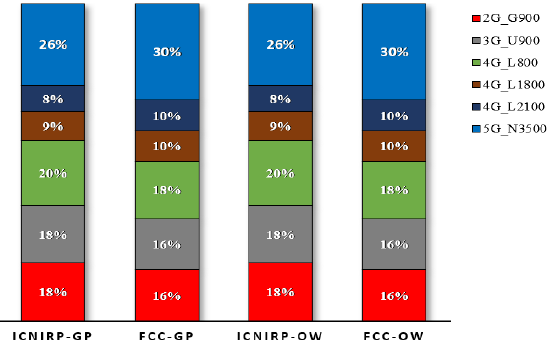
Figure 14. The EMF radiation contribution from each technology at CD for shared IBS site, referencing ICNIRP and FCC limits for GP and OW. Similar to that of the shared macro site, with an increase in the number of MNOs, the R CD of the IBS increased with the same percentage for all references. Table 5 summarizes the percentage of the distance increase compared with a single MNO with reference to the ICNIRP and FCC limits. It shows an increase of +41% for two MNOs, +73% for three MNOs, and 100% for four MNOs. Table 5. DC for IBS site shared by up to 4 MNOs, referencing the ICNIRP and FCC limits.